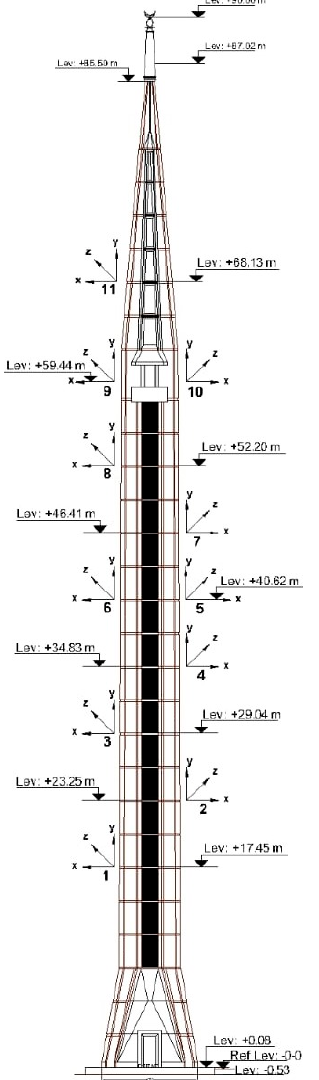
Figure 4. The schematic diagram for the sensor arrangements.